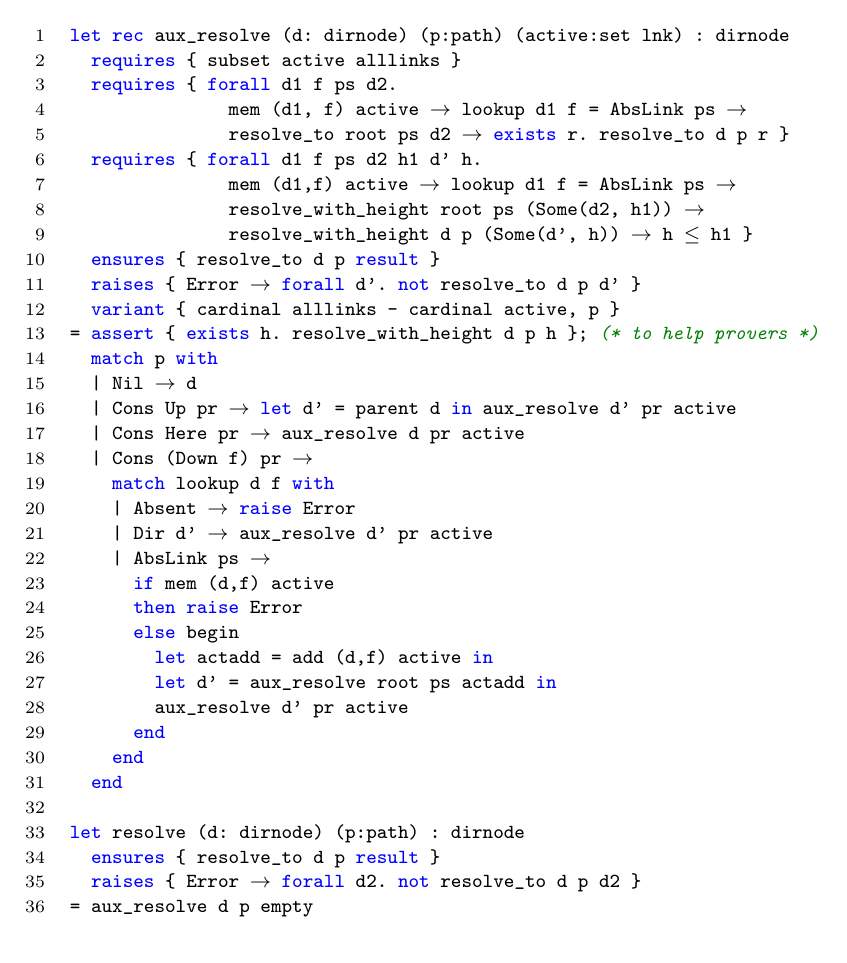
Fig. 5. Code annotated with formal